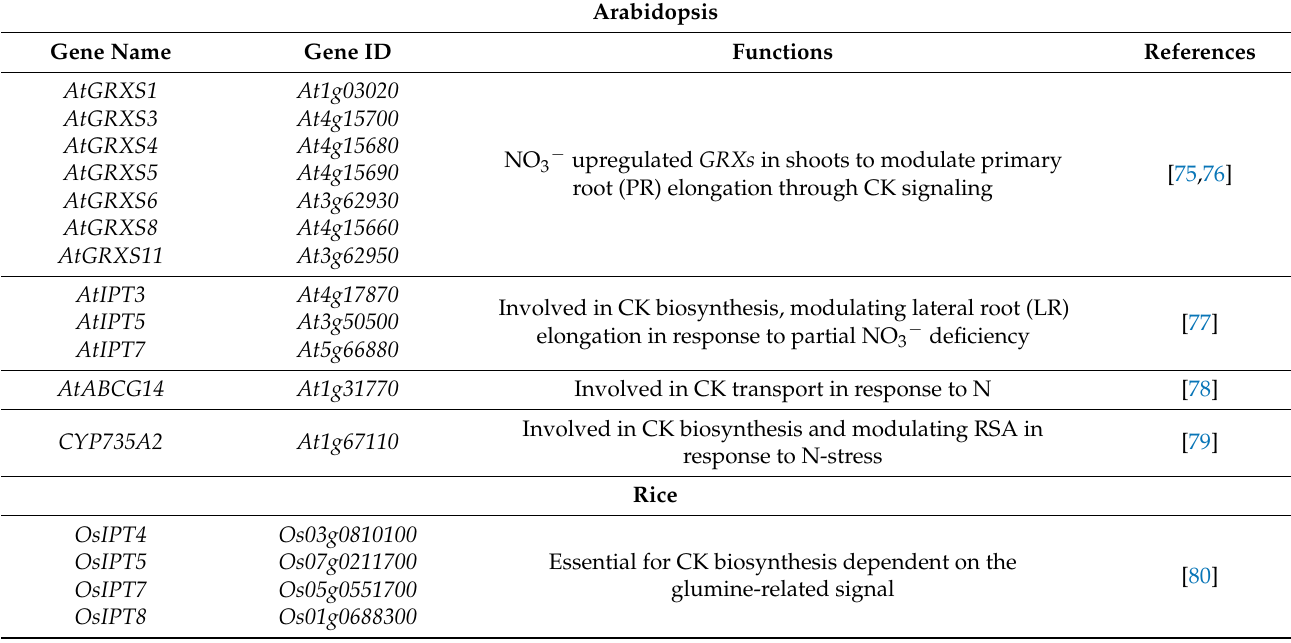
Figure 2. The interplay of nitrogen and phytohormones. The white box displays the identified molecular players. Positive, negative, and complex effects are indicated by green, red, and black lines, respectively. Known or putative links are marked with plain lines and dashed lines. Question marks indicate unconfirmed results. Table 1. List of genes and their roles associated with N stress and CK in Arabidopsis and rice.